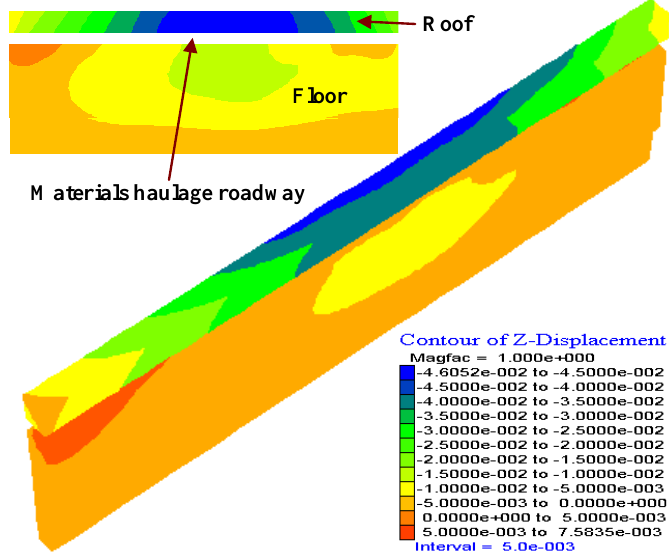
Figure 12. Z-displacement of materials haulage roadway when mining distance 140 m.